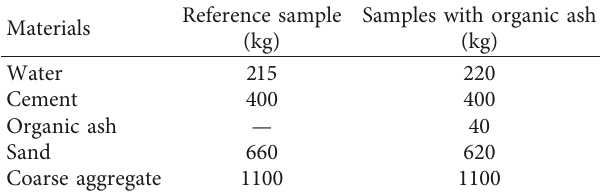
Table 5: Organic ash amounts in